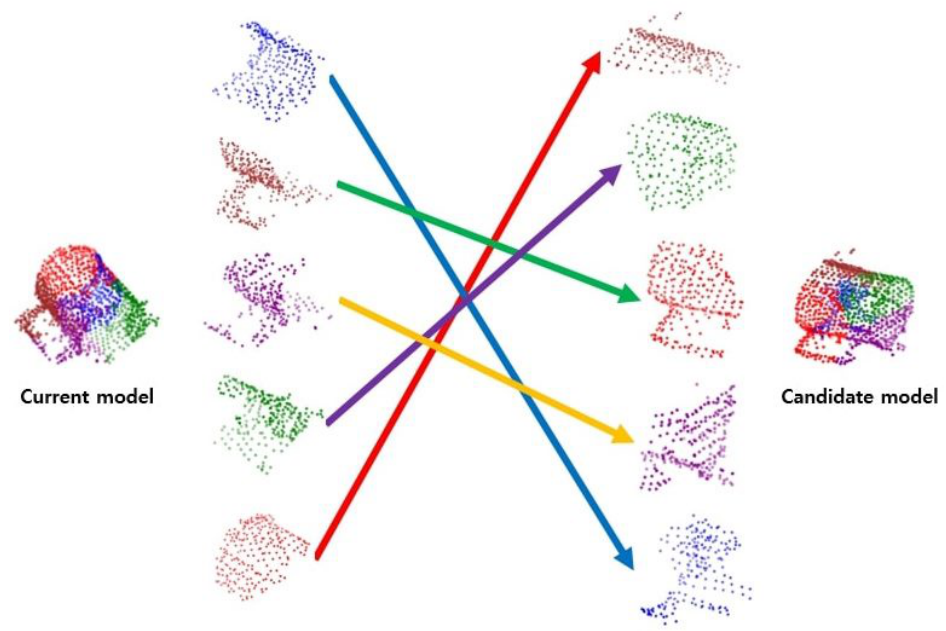
Figure 12. Matching models with